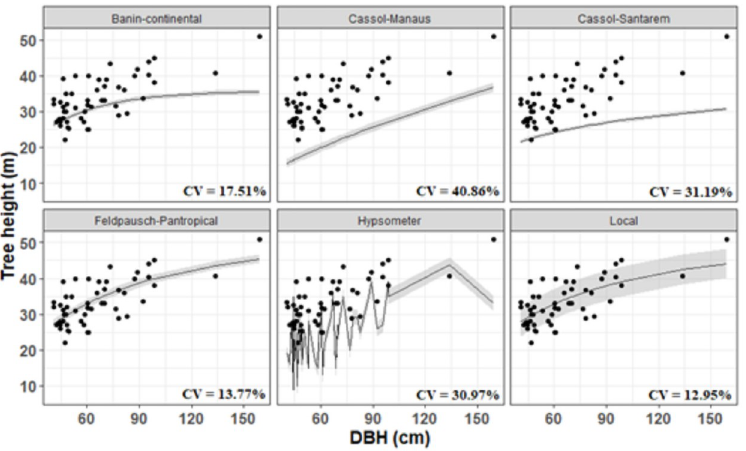
Fig 4. Estimates and percentage errors of allometric models (local, regional, continental and pantropical) and hypsometer for prediction of total height in tropical rainforest in Amapa´.